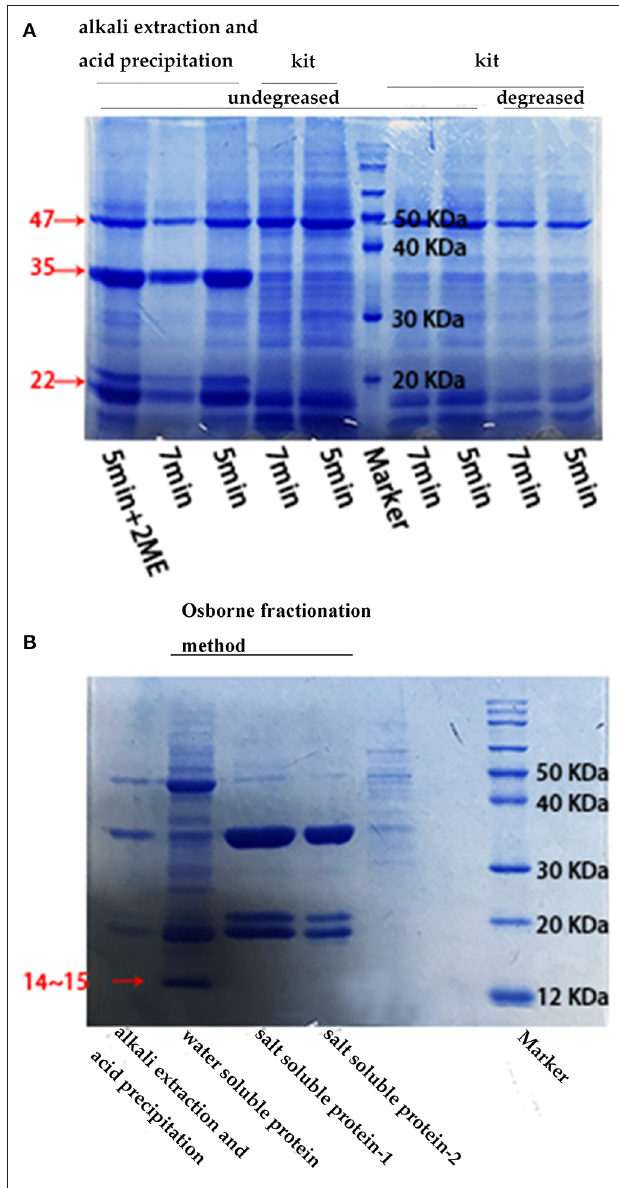
FIGURE 2 | SDS-PAGE results under different conditions. (A) SDS-PAGE electrophoresis of defatted/undefatted hempseed protein extracted using different methods. The time indicated the protein boiling time at 95 ◦ C and the 2ME concentration was 2.5%; (B) SDS-PAGE electrophoresis of raw hempseed protein extracted using the “acid precipitation and alkaline extraction” method and the Osborne fractionation method (for water-soluble and salt-soluble proteins, respectively). The salt-soluble protein-1 was extracted using NaCl, while the salt-soluble protein-2 was extracted using urea. The concentrations of NaCl was 1M and of urea was 8M, the boiling time was